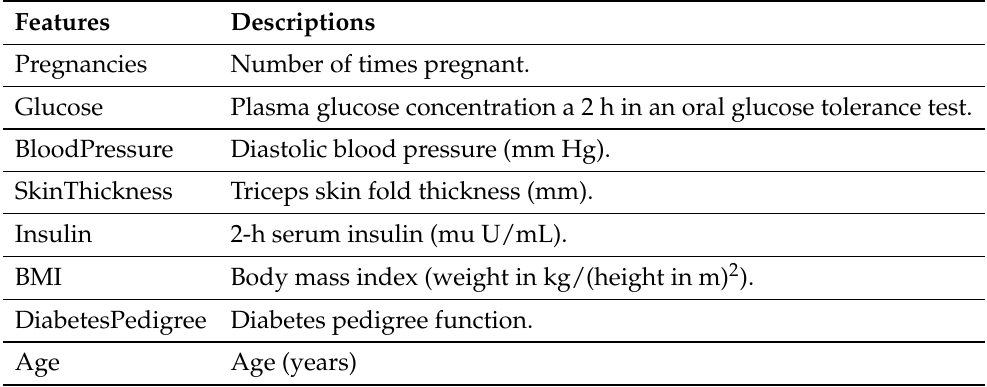
Table A3. Feature description for the Prima Indians diabetes mellitus classification dataset.